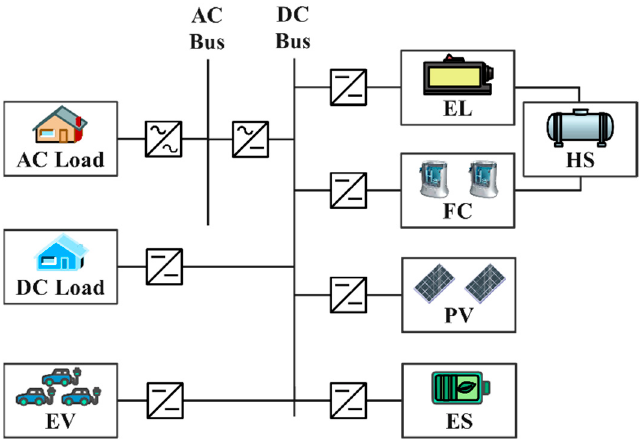
Figure 1. Structure of PV-hydrogen zero carbon emission microgrid system.